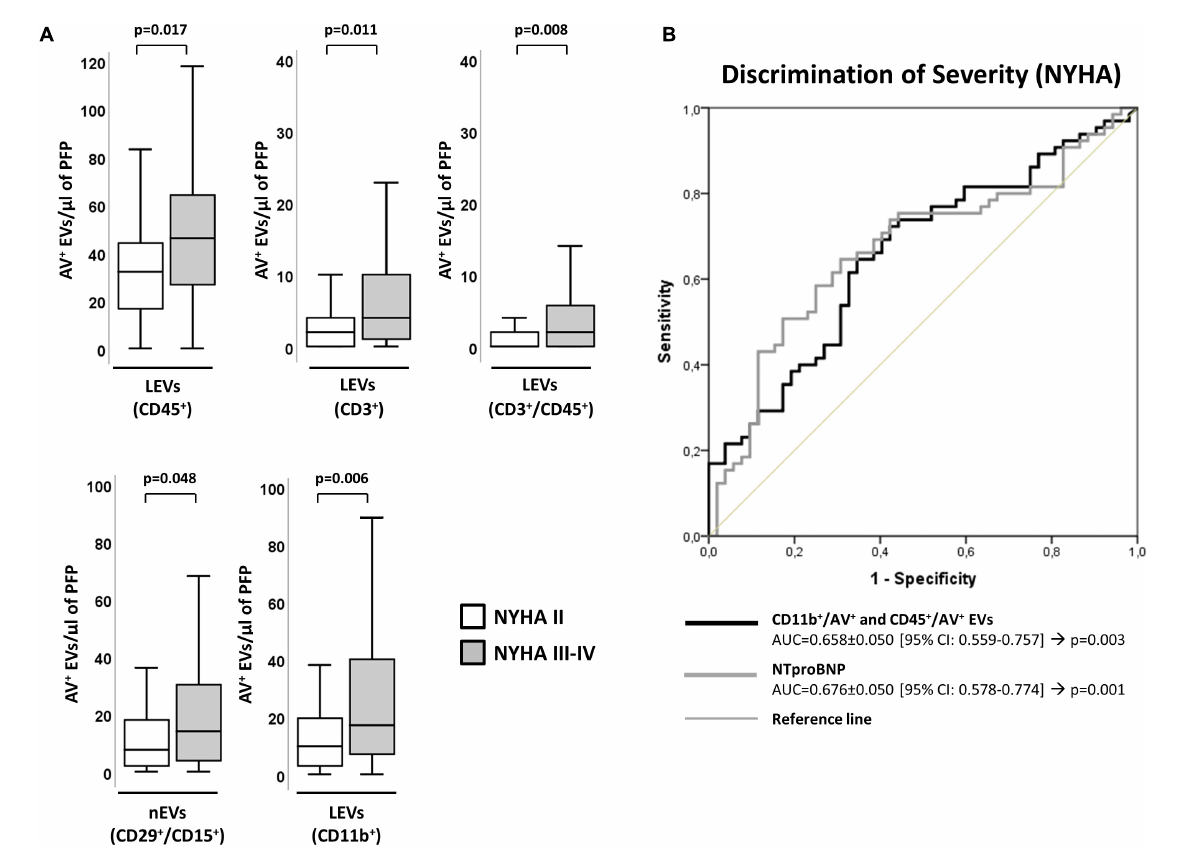
FIGURE2 Distribution of AV + -EVs of immune-cell origin considering disease severity according to NYHA. (A) Distribution of EVs from total leukocytes (CD45 + ), T-lymphocytes (CD3 + and CD3 + /CD45 + ), activated leukocytes (CD11b + ) and from activated neutrophils (CD29 + /CD15 + ). A p < 0.05 was considered significant (U Mann–Whitney test). (B) ROC curve analyses to evaluate EVs and NT-proBNP association to NYHA severity, with AUC indicated along its 95% CI. A p < 0.05 was considered significant. AUC, area under the curve; AV + , annexin V + ; cHF, chronic heart failure; CI, confidence interval; EVs, extracellular microvesicles; LEVs, leukocyte-derived EVs; lEVs, lymphocyte-derived EVs; nEVs, neutrophil-derived EVs; NYHA, New York Heart Association; PFP, platelet-free plasma; ROC, receiver operating characteristic